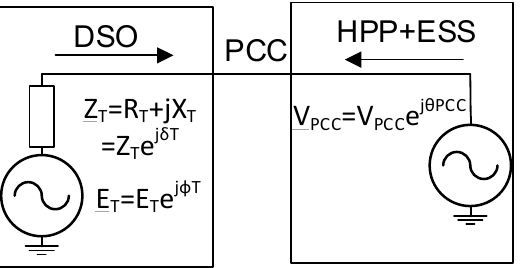
Figure 11. Simplified one-phase Thevenin’s equivalent circuit used for a rough estimation of the influence of power capacity of considered hydro power plant and energy storage system on voltage level.